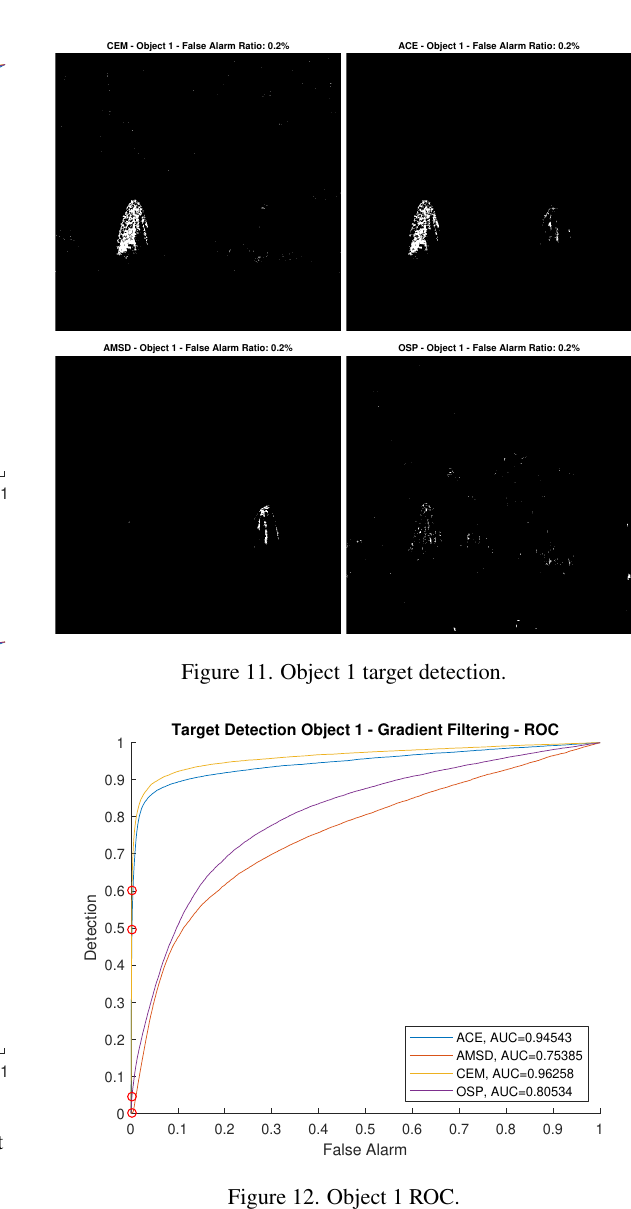
Figure 12. Object 1